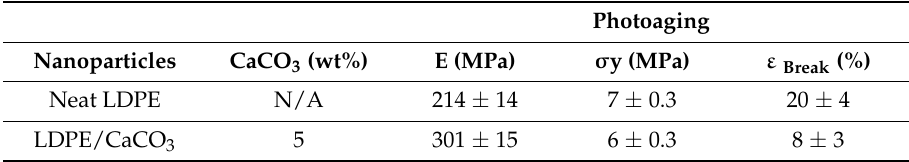
Table 4. Mechanical properties of LDPE and LDPE/CaCO 3 nanocomposites after irradiation during 10 days.